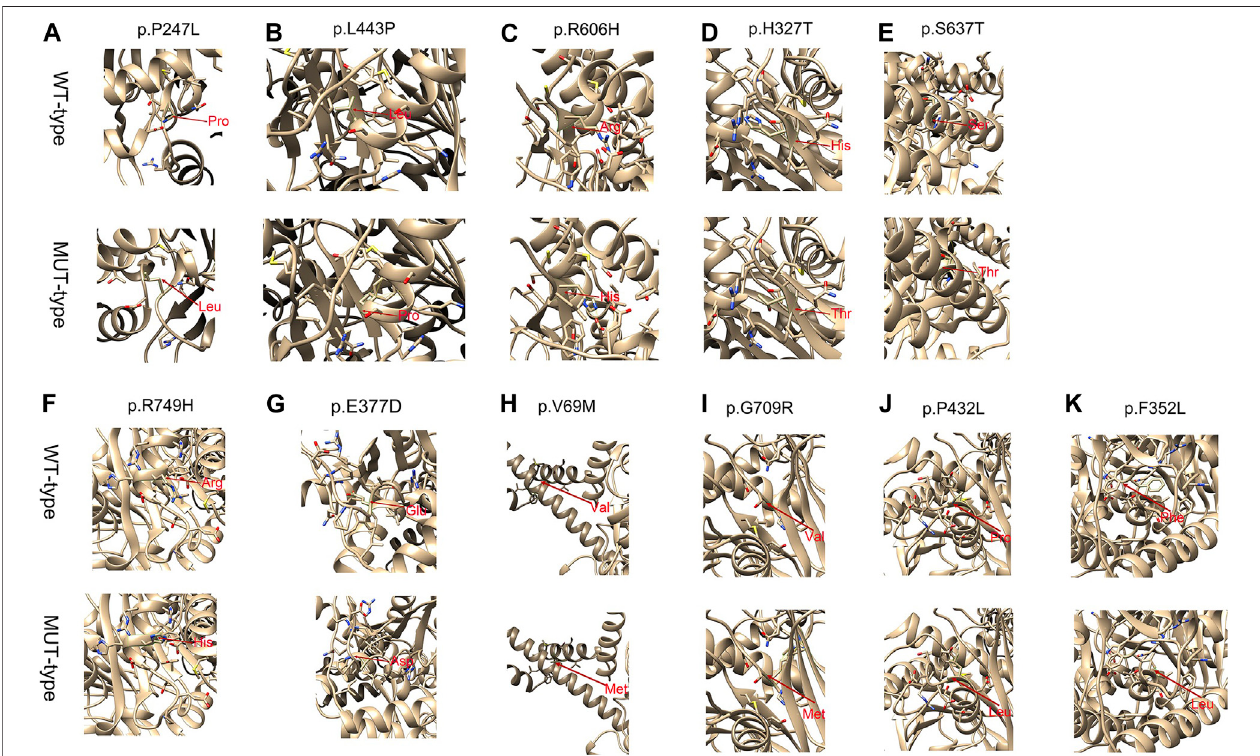
FIGURE1| Structure stability analysisofthep.P247L,p.L443P,p.R606H, p.H327T, p.S637T, p.R749H, p.E377A, p.V69M, p.G709R, p.P432L mutations on the partial tertiary structure of CPT1Aprotein (Uniprot: AF-P50416-F1). Structure stability analysis of the p.F352L mutation on the partial tertiary structure of CPT2 protein (Uniprot: AF-P23786-F1). A: The wildtype amino-acid residue at 247 site, 443 site, 606 site, 327 site, 637 site, 749 site, 377 site, 69 site, 709 site, 432 site and 352 site (CPT2 protein) colored green has no contact with the amino-acid residue nearby. (A) base on this model, after amino-acid was substituted by the Leucine amino acid residue at this site, fi ve atoms clash and contacts were found in this region. (B) After amino-acid was substituted by the Proline amino acid residue at this site, fi ve atomsclash and contacts werefoundinthisregion. (C) Afteramino-acid wassubstituted bytheHistidineaminoacidresidue atthissite, three atoms clashand contacts werefoundinthisregion. (D) Afteramino-acidwassubstitutedbytheThreonine aminoacidresidueatthissite,noatomclashandcontactswerefoundinthisregion. (E) After amino-acid was substituted by the Threonine amino acid residue at this site, one atoms clash and contacts were found in this region. (F) After amino-acid was substituted bytheHistidineaminoacid residue at thissite, three atomclash and contacts werefound inthisregion. (G) Afteramino-acid wassubstituted bythe Aspartic acidresidueatthissite,0atomsclashandcontactswerefoundinthisregion.HAfteramino-acidwassubstitutedbytheMethionineaminoacidresidueatthissite,seven atomsclashandcontactswerefoundinthisregion. (I) Afteramino-acidwassubstitutedbytheArgnineaminoacidresidueatthissite,37atomsclashandcontactswere found in this region. (J) After amino-acid was substituted by the Leucine amino acid residue at this site, 0 atoms clash and contacts were found in this region (K) After amino-acid was substituted by the Leucine amino acid residue at this site, one atoms clash and contacts were found in this region. Amino acid change marked with red arrows. Atoms clash and contacts are shown in yellow lines. The Structure stability analysis of novel mutations were performed by Chimera version 1.15.